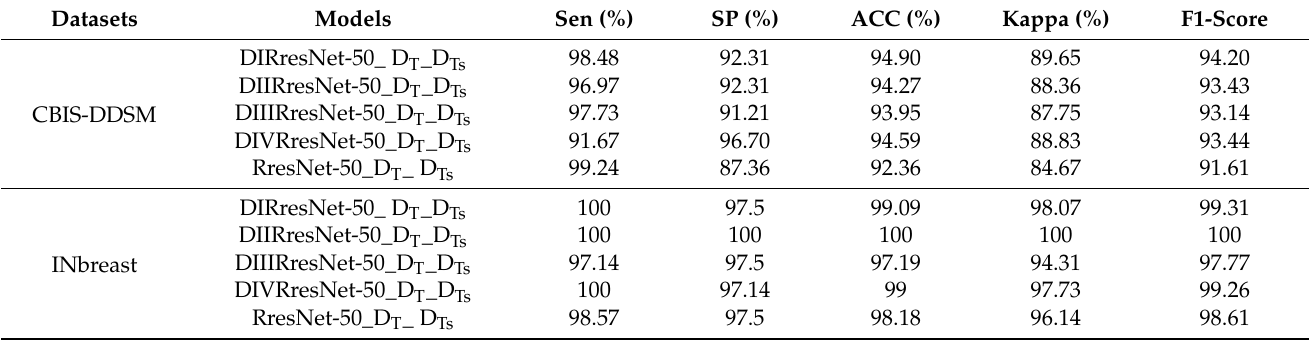
Table 9. The effect of density specific models, D*RresNet-50_D* Ts means the ResNet-50 model adapted for density type “*”, Fine-tuned with the training dataset D* T and was tested on test dataset D* TS . Datasets Models Sen (%) F1-Score